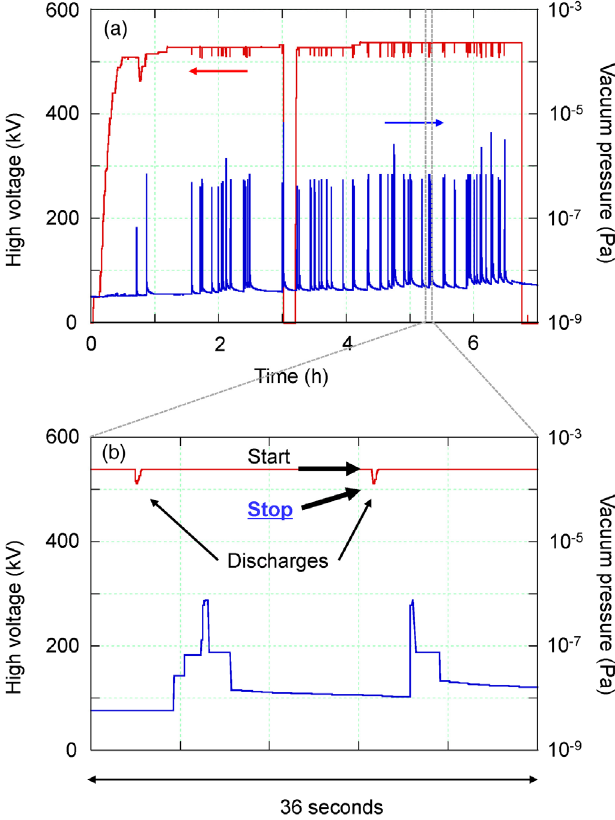
FIG. 9. (a) Typical HV conditioning as a function of time for 1 day. The HV is shown by the red curve and vacuum pressure is shown by blue curve. An enlargement of the time slot shown in (a) is plotted in (b). When discharge occurs, the HV drops and vacuum pressure rises. Discharge start and stop voltages are shown by thick black arrows.